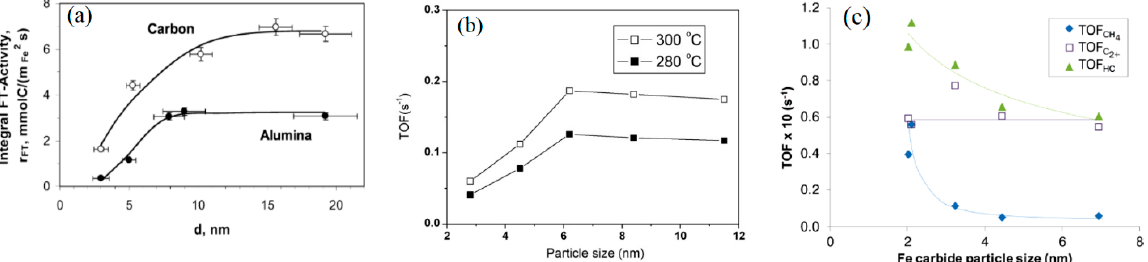
Figure 5. ( a ) Initial integral activity per unit surface area over carbon supported iron-based catalysts at 270 °C and 3.0 MPa H 2 /CO = 2, 7.2 NL/g-cat/h, and X CO = 20–75%; alumina-supported catalysts: 18 NL/g-cat/h, and, X CO = 6–15% (from [51]), ( b ) The influence of iron particle size on the TOF at 280 and 300 °C, 1.0 MPa, 7.2 NL/g-cat/h, and H 2 /CO = 2.0 (reproduced with permission from [52] Copyright 2010, Elsevier), ( c ) TOF as a function of iron carbide size 340 °C, 2.0 MPa, H 2 /CO = 1, (reproduced with permission from [53] Copyright 2012, ACS).